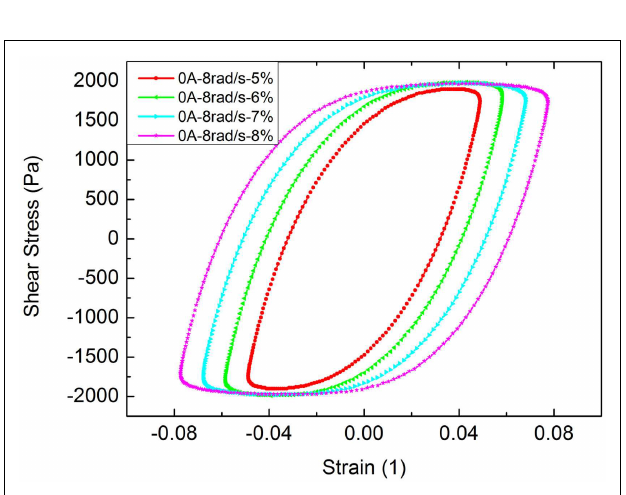
FIGURE 4 | Linear relationship between shear strain and shear stress .